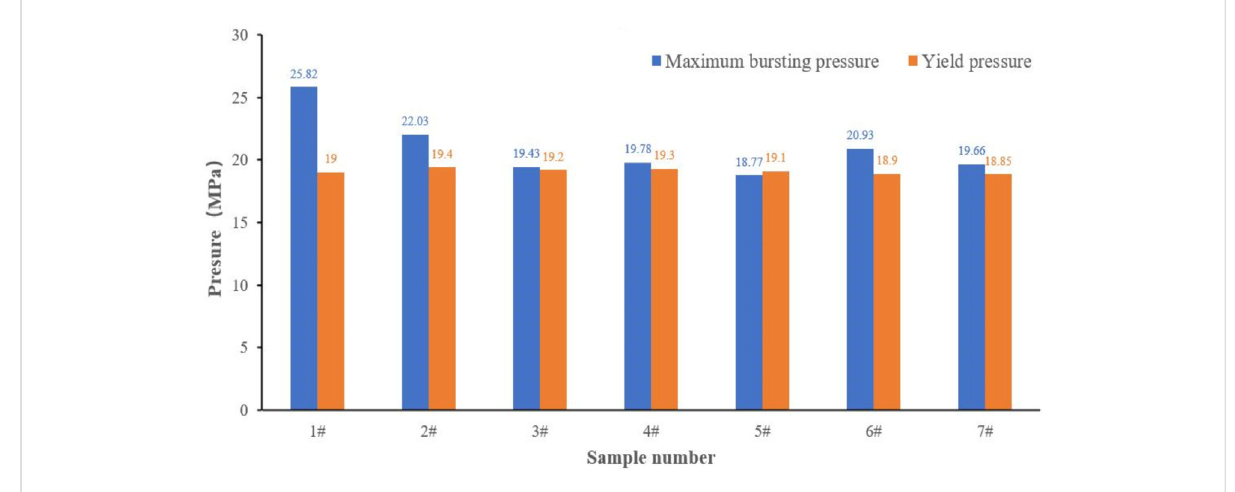
FIGURE 8 Curves of yield pressure and maximum bursting pressures of seven